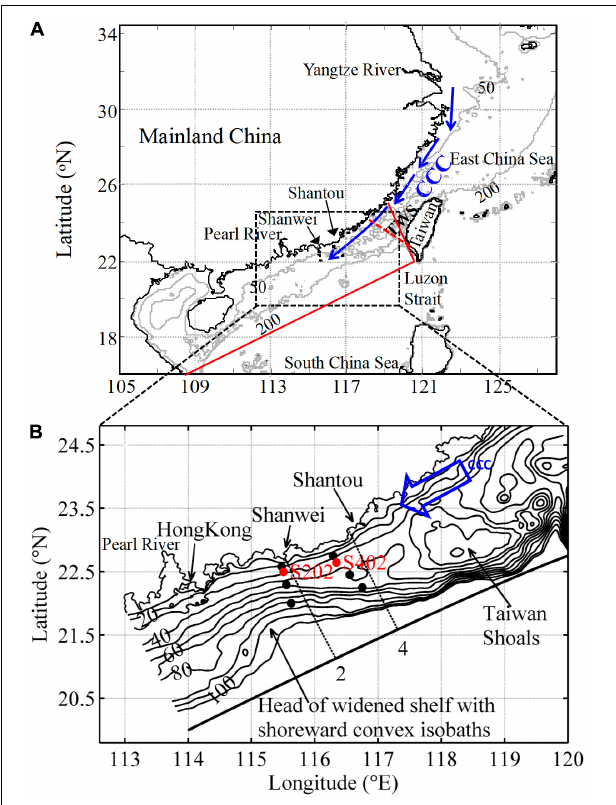
FIGURE 1 | (A) Map of the study area in the northeastern South China Sea (NSCS) and the adjacent East China Sea (ECS) and the Taiwan Strait (TWS). The schematic China Coastal Current (CCC) introduced by Han et al. (2013) is indicated by blue arrows. The Regional Ocean Modeling System (ROMS) model domain is indicated by red solid lines and biological forcing along the southern TWS boundary in winter (Naik and Chen, 2008) is marked by the red dashed line. (B) Bathymetry (in m) of the NSCS shelf. The dashed lines represent Transects 2 and 4 offshore of Shanwei and Shantou, respectively. Solid circles show the location of the field survey stations, with stations s202 and s402 shown in red. The shoreward convex isobath is at the head of the widened shelf, ∼ 0.5 o southwest of Shanwei. Horizontal maps are zoomed in to clearly show the region of interest. The blue arrow again indicates the southward